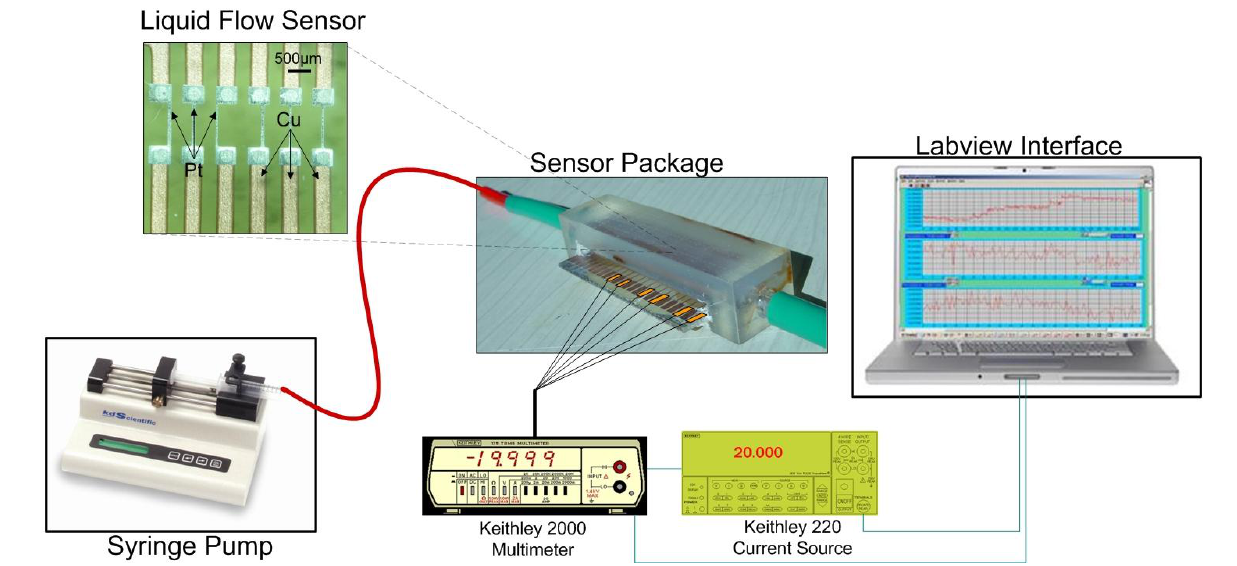
Figure 3. A schematic of the measurement setup used. A syringe pump provides the reference flow to the sensor package. A current source is used to provide the heater operating current, while the resistance variation of the resistors is recorded by a multimeter equipped with a 10-channel scan card. The obtained data are monitored through a